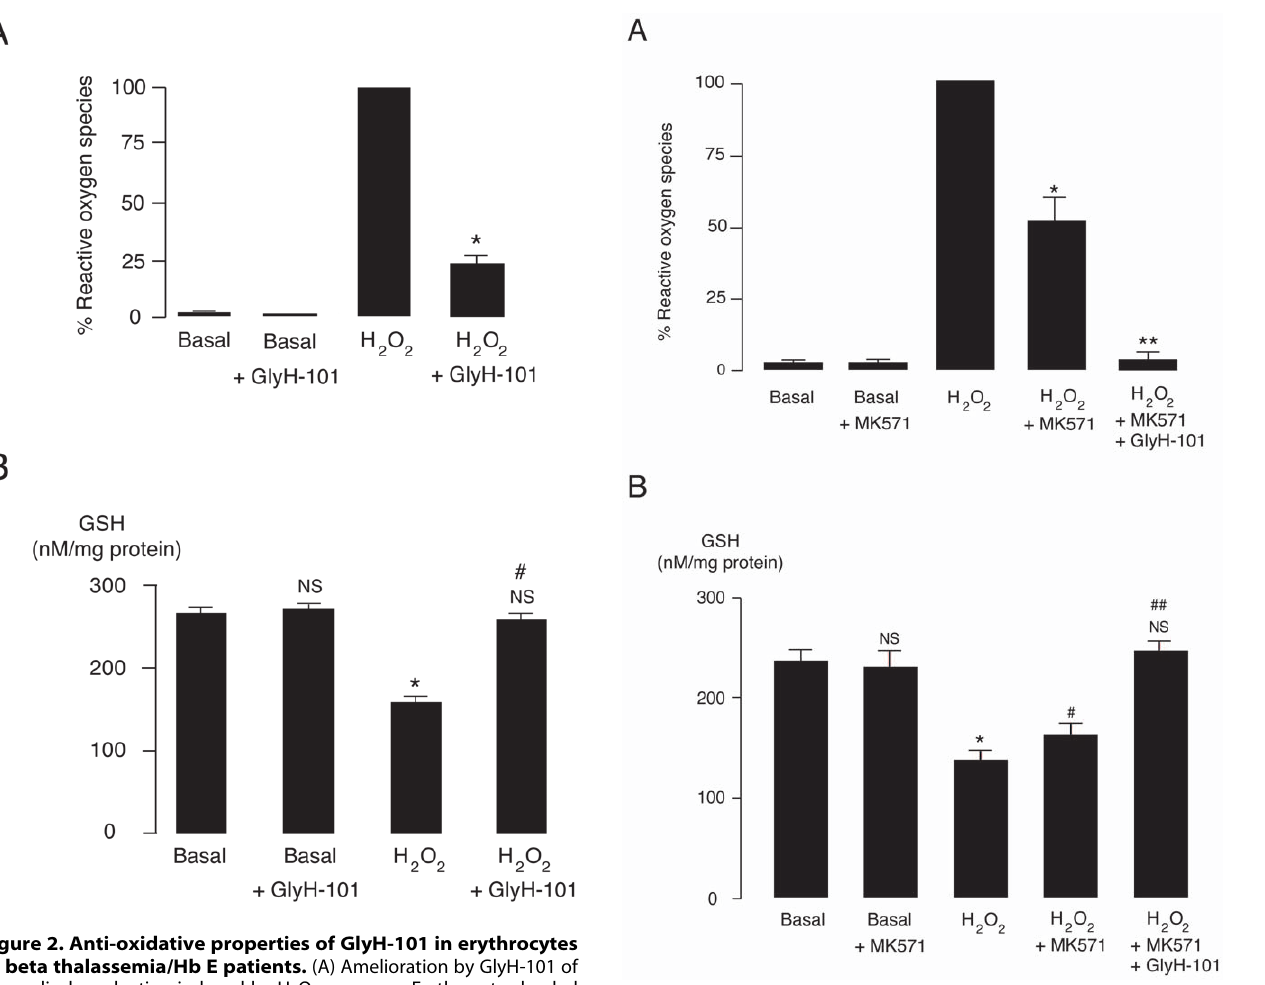
Figure 3. Anti-oxidative properties of MK571 in erythrocytes of beta thalassemia/Hb E patients. (A) MK571 reduced H 2 O 2 -induced free radical production. Erythrocytes loaded with DCFH-DA were incubated for 1 h with DMSO (basal), DMSO plus MK571 (basal + MK571), H 2 O 2 (10 mM), H 2 O 2 plus MK571 (50 m M) or H 2 O 2 plus MK571 and GlyH-101 (50 m M). Reactive oxygen species were measured by flow cytometry analysis at excitation wavelength of 490 nm and emission wavelength of 530 nm. Data were expressed as means 6 S.E. *, p , 0.05; **, p , 0.001 compared with H 2 O 2 -treated group (n=12). (B) Effect of MK571 on intracellular glutathione levels. Erythrocytes were treated for 1 h without (basal) or with H 2 O 2 (10 mM) in the presence or absence of MK571 (50 m M) or MK571 plus GlyH-101 (50 m M) before measurements of GSH levels. Data were expressed as means 6 S.E. NS, non-statistical significant difference from basal control; *, p , 0.01 compared with basal control; # , p , 0.05; ## , p , 0.01 compared with H 2 O 2 -treated group